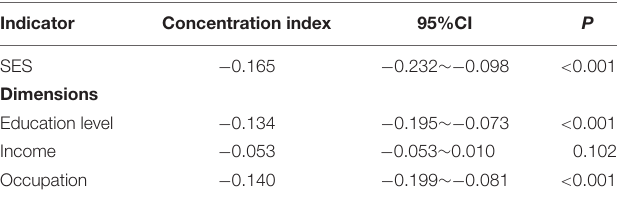
TABLE 4 | Concentration index of cognitive impairment in the elderly under different socioeconomic status indicators.